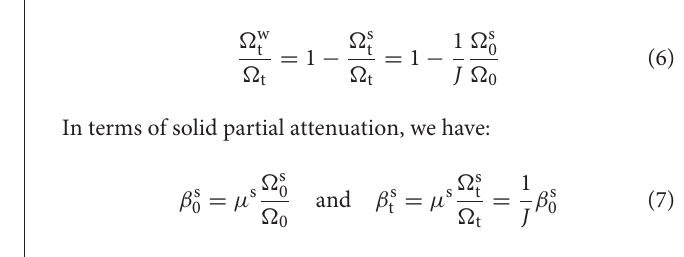
FIGURE 7 | Displacement field as measured with Global DVC. The displacement at the nodes of the mesh is shown with vectors scaled up by 25 × , and whose colour represents the norm of the vector. The mesh is shown in its reference state (i.e., in 002).